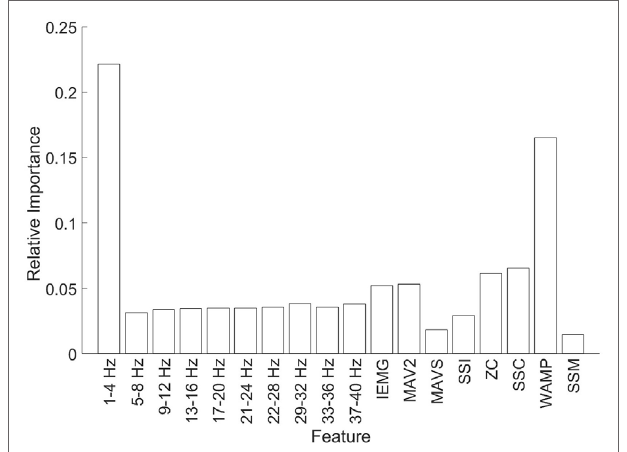
FigUre 7 | relative importance for each feature . The first 10 bars correspond to the EEG features, while the last 8 correspond to EMG.